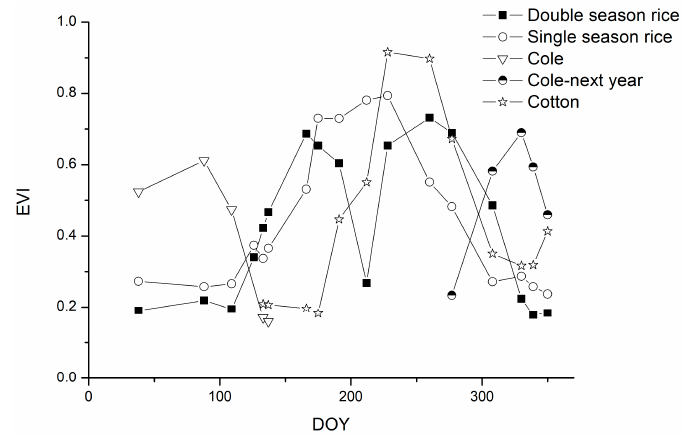
Figure 7. EVI time profiles for dominant crops in the study area during 2016 (DOY is day of year.).